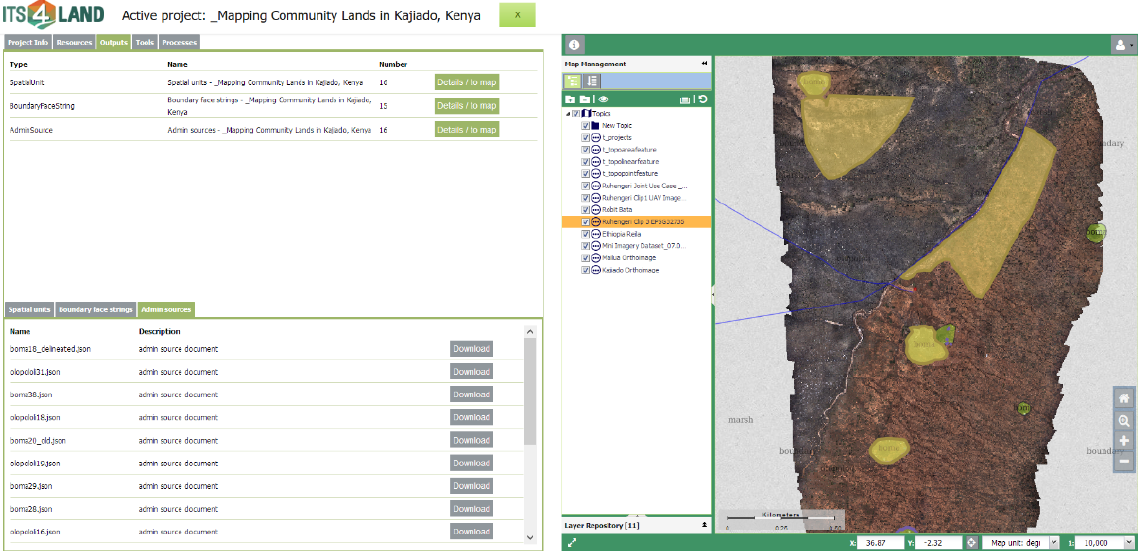
Figure 5. Result of Processing by the SmartSkeMa tool.